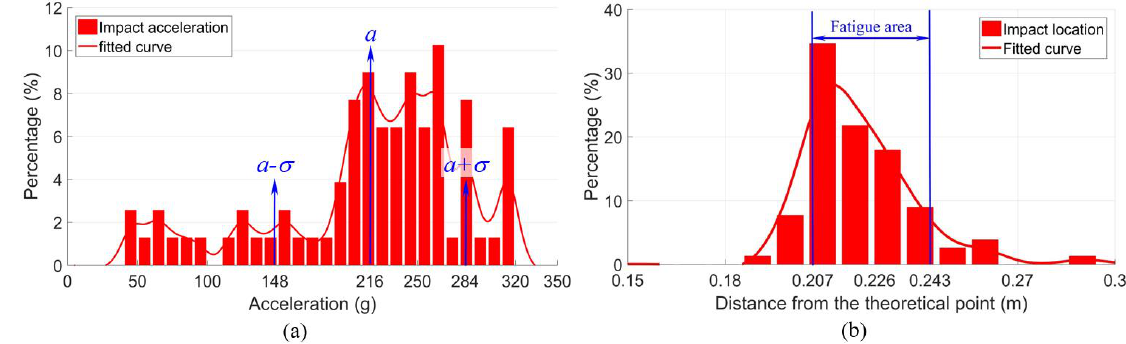
Figure 21. Measured dynamic responses: ( a ) wheel impact distribution and ( b ) impact location distribution.